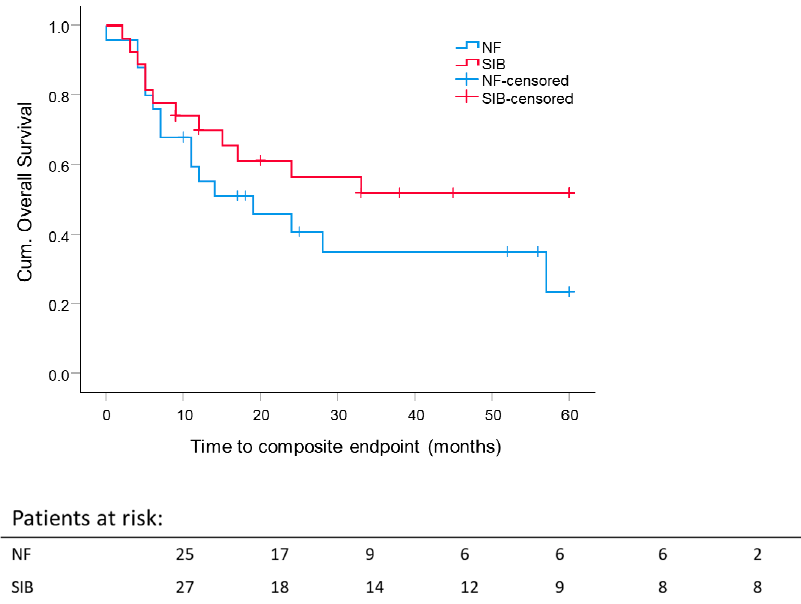
Figure 5. Impact of boost concept on 5 year composite overall survival: Kaplan–Meier curves for each analyzed group were calculated from the date of diagnosis. p = 0.177.